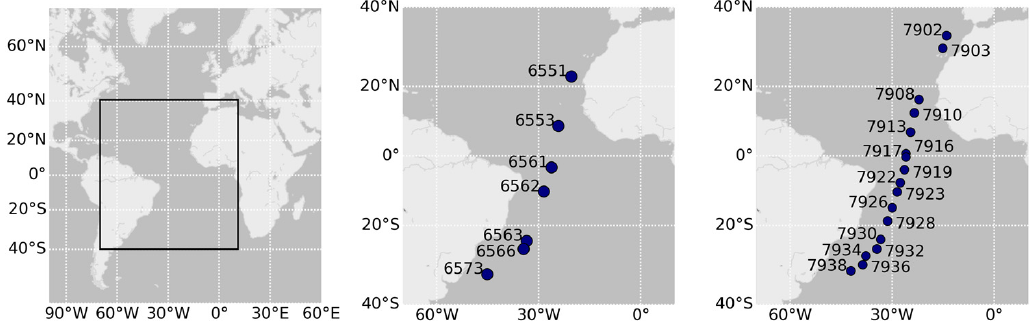
Figure 1. Station map for surface ( middle ) and subsurface ( right ) samples.